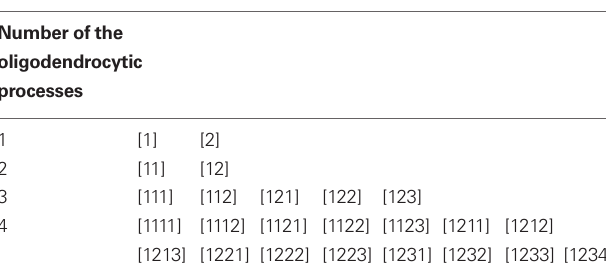
Table 2 | The Bell number B ( n ) indicates how many categories n processes of oligodendrocytes can